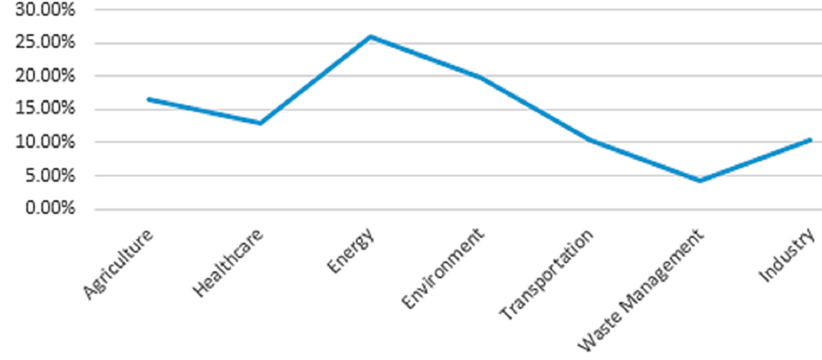
Figure 19. Rate of publications related to different smart cities subcategories.